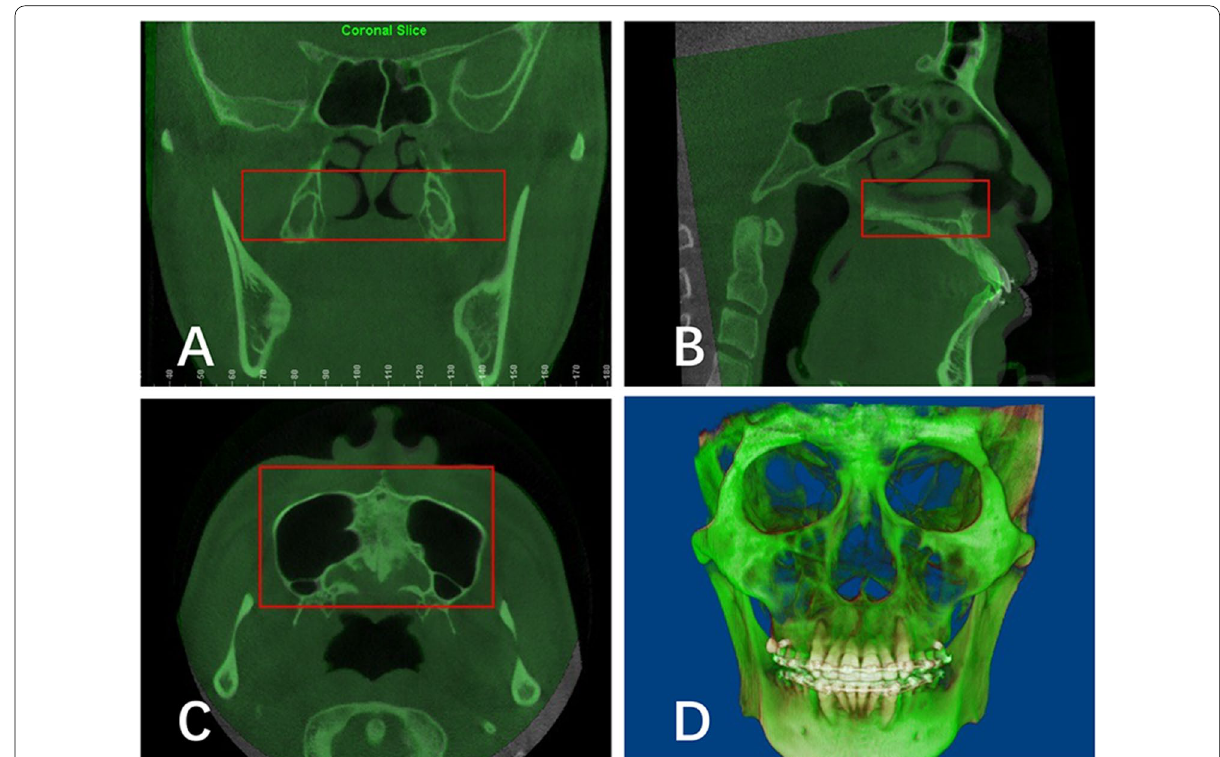
Fig. 2 Voxel-based superimposition of pre-retraction and post-retraction CBCT based on the maxillary region. A The coronal, B sagittal, C axial and D 3-D frontal view of superimposition